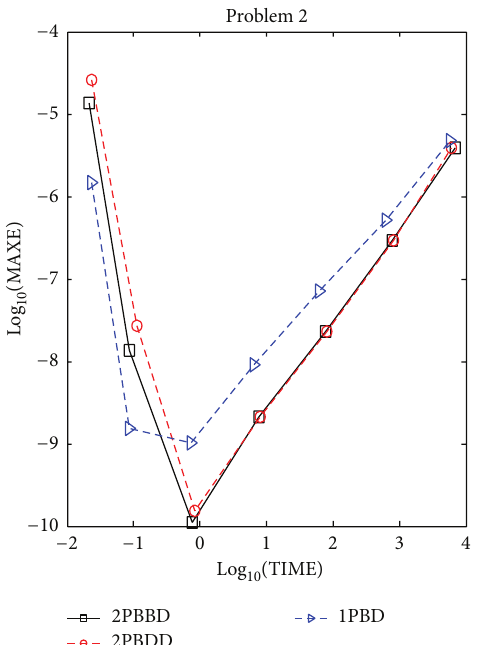
Figure 7: Graph of Log 10 ( MAXE ) plotted against Log 10 ( TIME ) for Problem